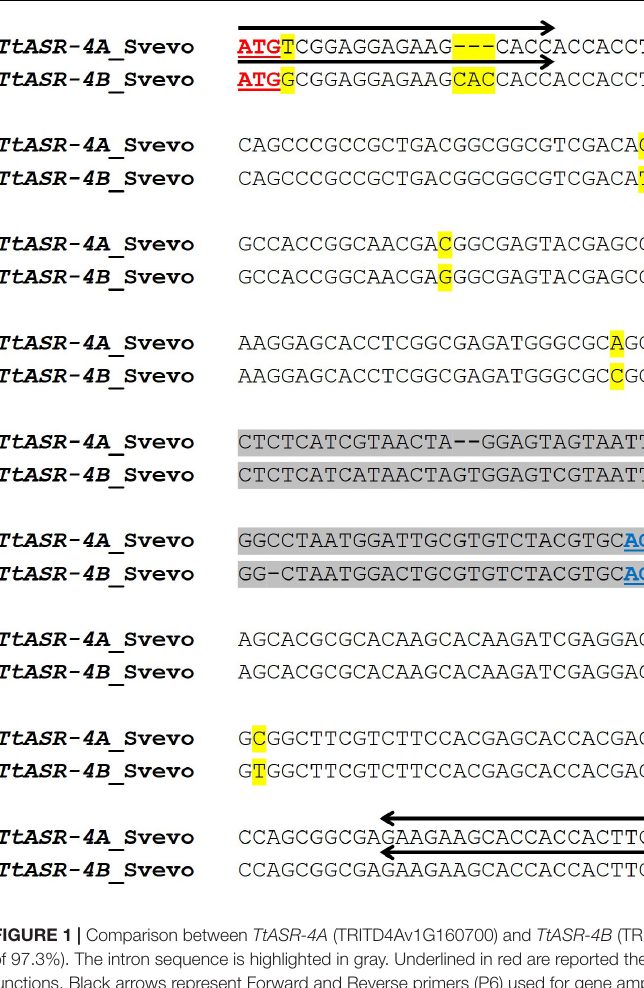
Frontiers in Plant Science |